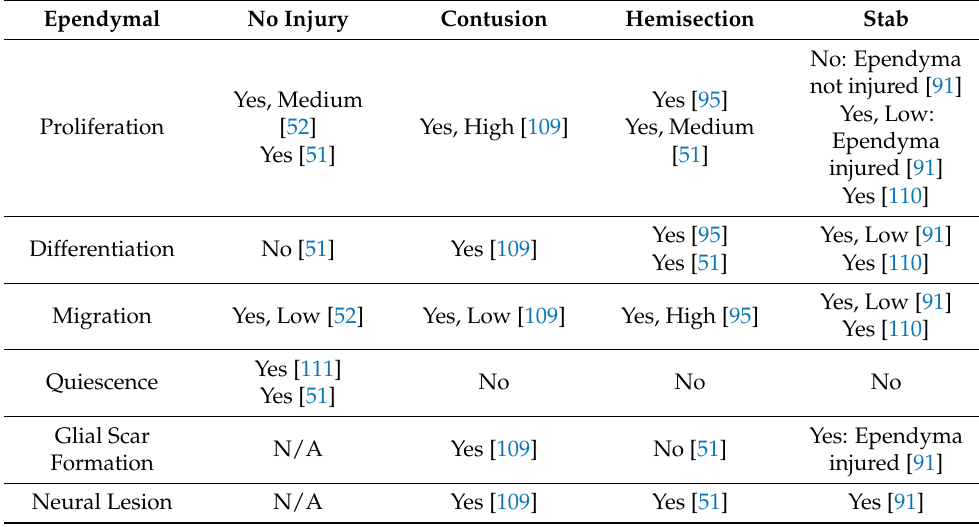
Table 1. Ependymal and NG2+ cell activity: normal physiology vs.